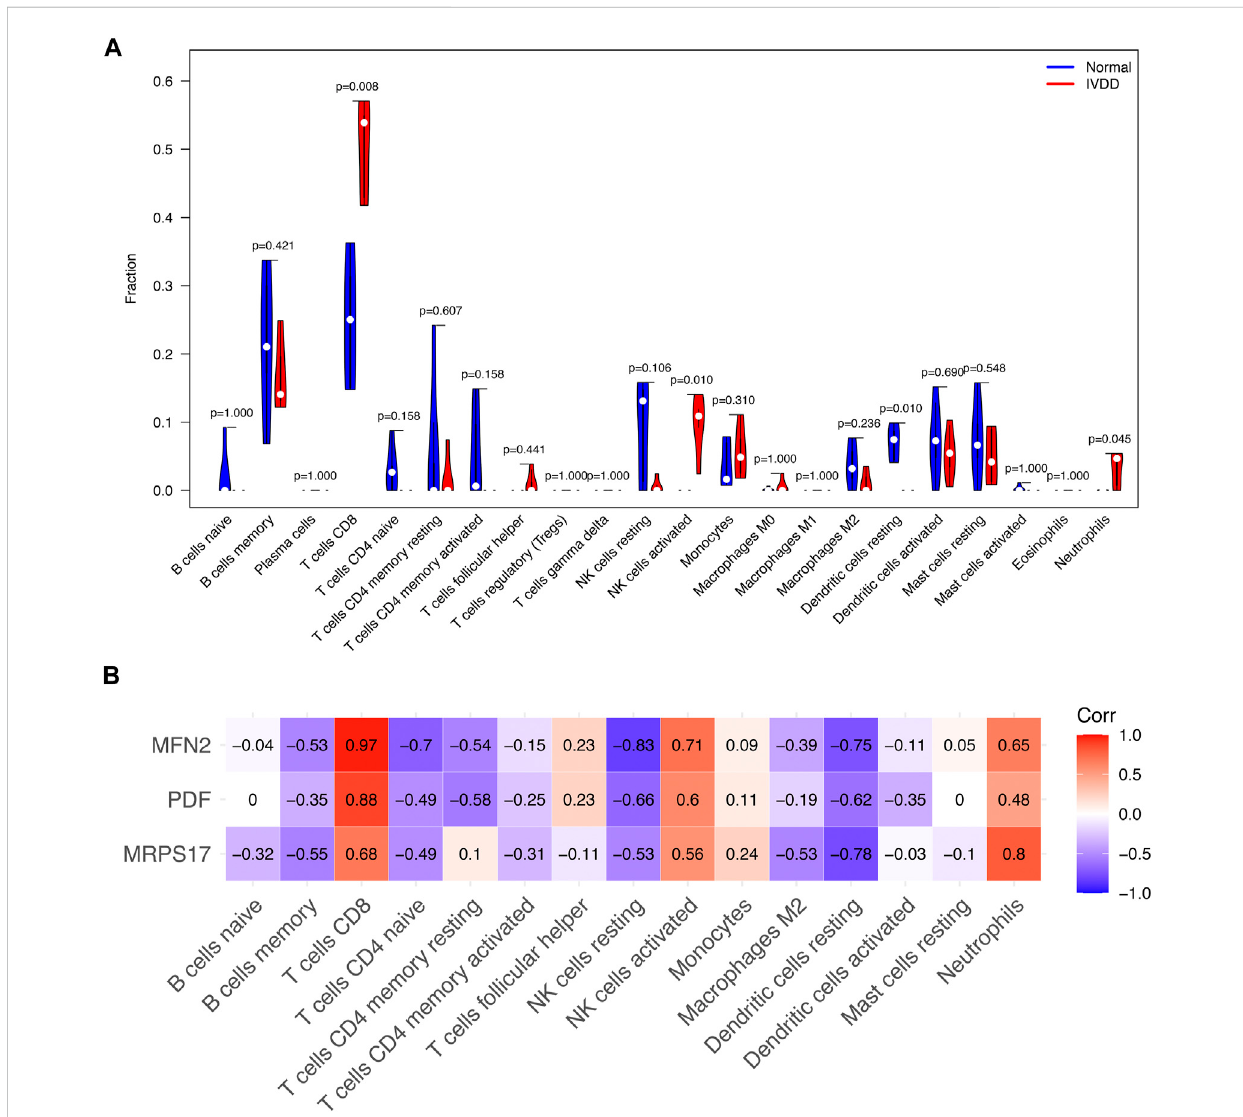
FIGURE 6 Signaturegenesrelatedtoimmunecellin fi ltration. (A) Thein fi ltrationofimmunecellsintheNPtissuesoftheIVDdegenerationandhealthysubjects. (B) The relationship between signature genes and immune cell in fi